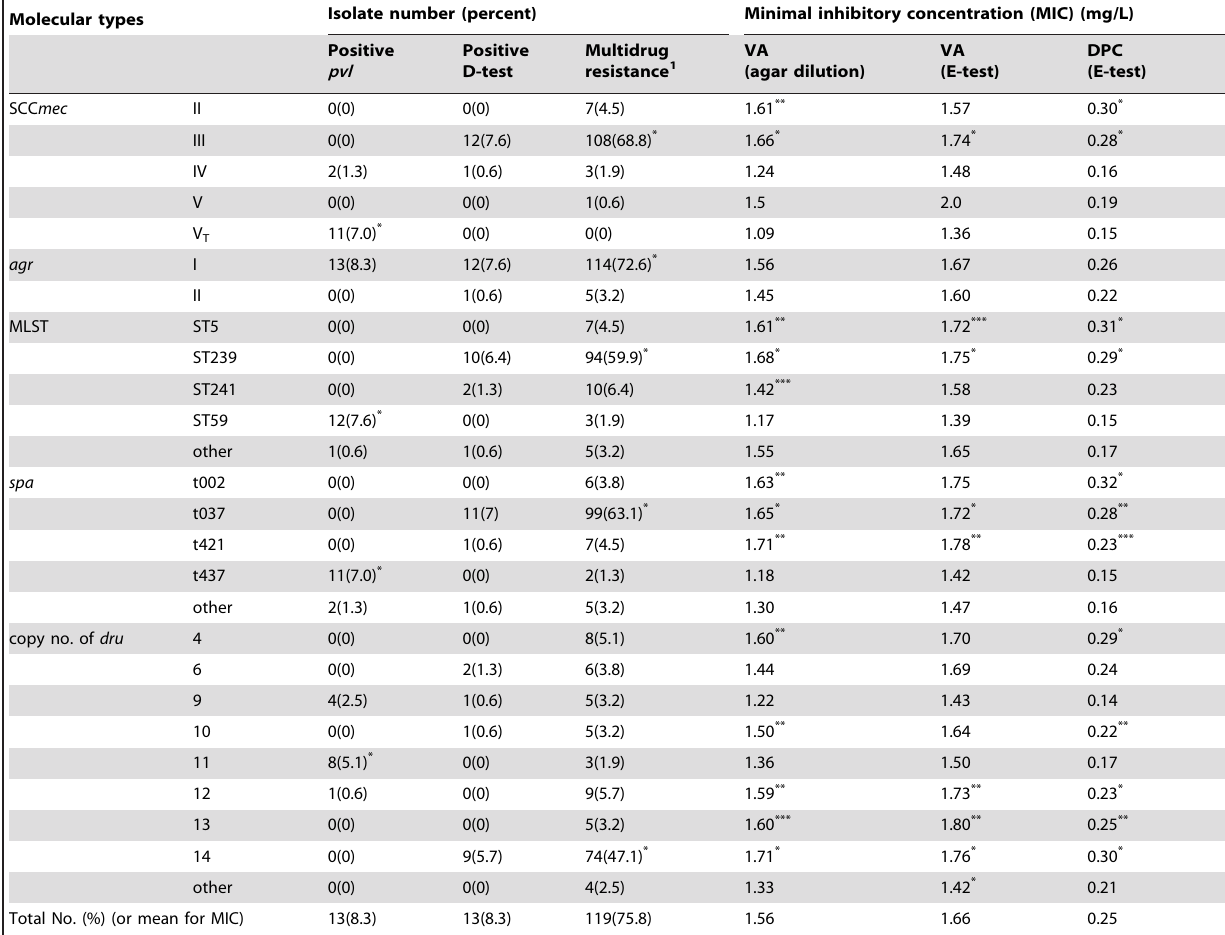
Table 1. Correlations between molecular types and phenotypes of MRSA blood